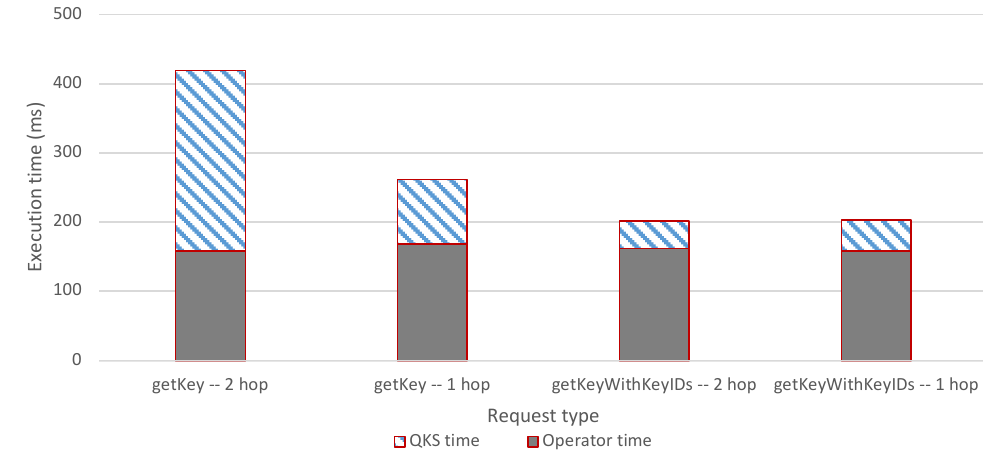
Figure 10. Execution time of the getKey and getKeyWithId functions for Point-to-Point and Multi- hop